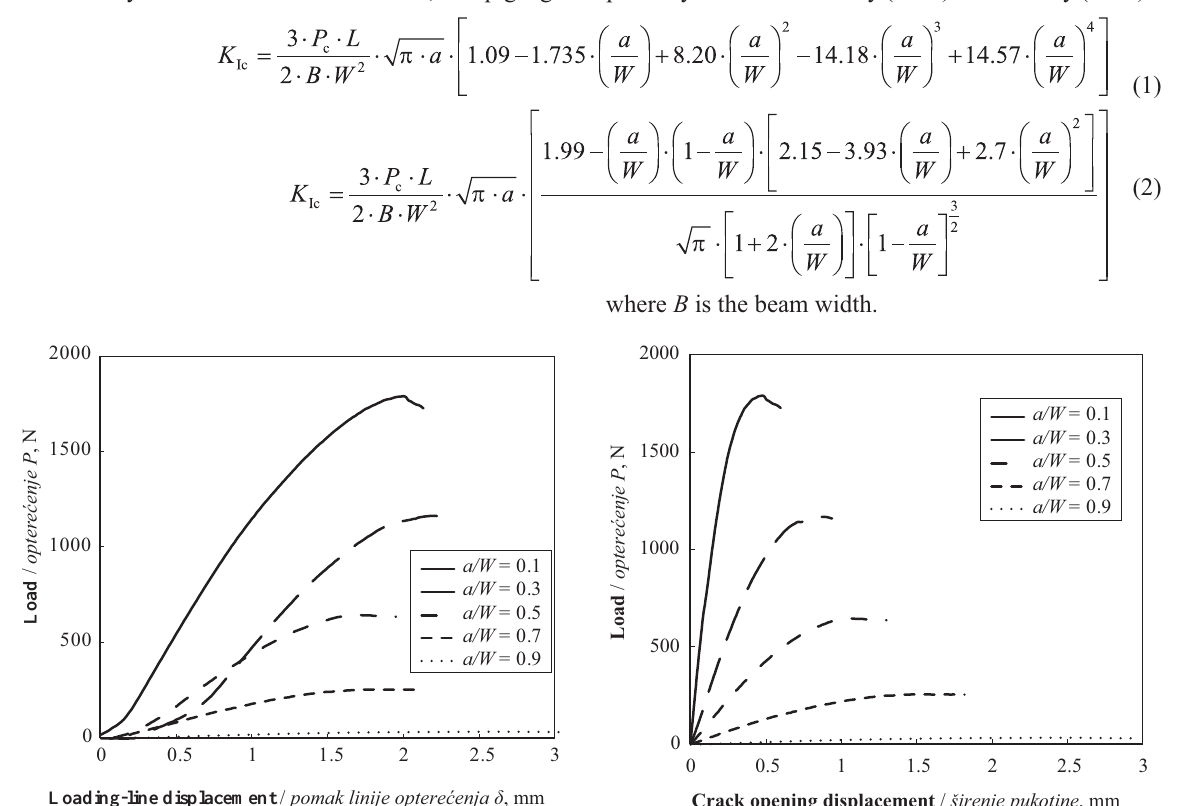
Figure 2 Typical example of the relationship between load P and loading-line displacement δ and that between P and the crack opening displacement COD for various crack lengths a in SENB test. Depth of the specimen W = 40 mm Slika 2 . Tipičan primjer odnosa između opterećenja P i pomaka linije opterećenja δ te između opterećenja P i širenja pukotine COD za različite duljine pukotine a u SENB testu; debljina uzorka W = 40